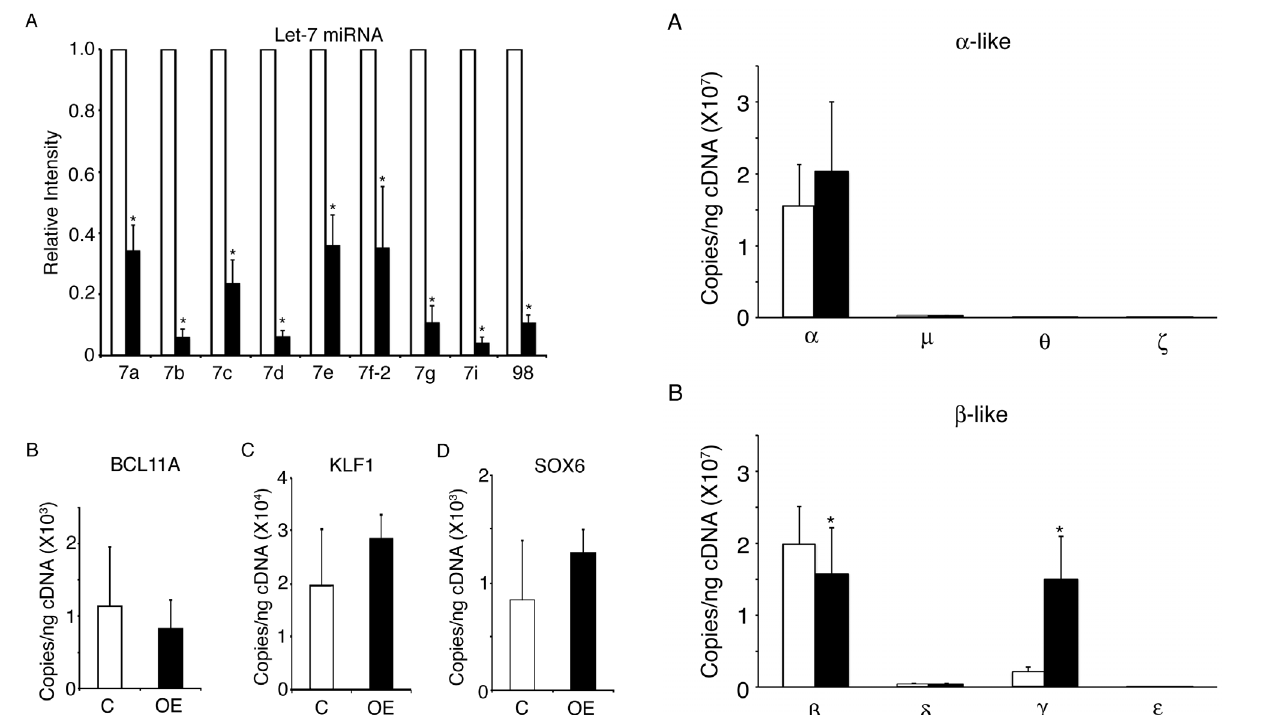
Figure 3. LIN28A regulates gamma-globin mRNA levels in cultured human sickle erythroblasts. LIN28A over-expression compared to control samples in the mRNA expression levels of (A) alpha -, mu -, theta - and zeta - globins and (B) beta -, delta -, gamma - and epsilon - globins . Analyses were performed at culture day 14. Open bars represent control and black bars represent LIN28A over-expression. Mean value 6 SD of five independent research subjects for each condition. P values were calculated using Student’s t-test. *p , 0.05.